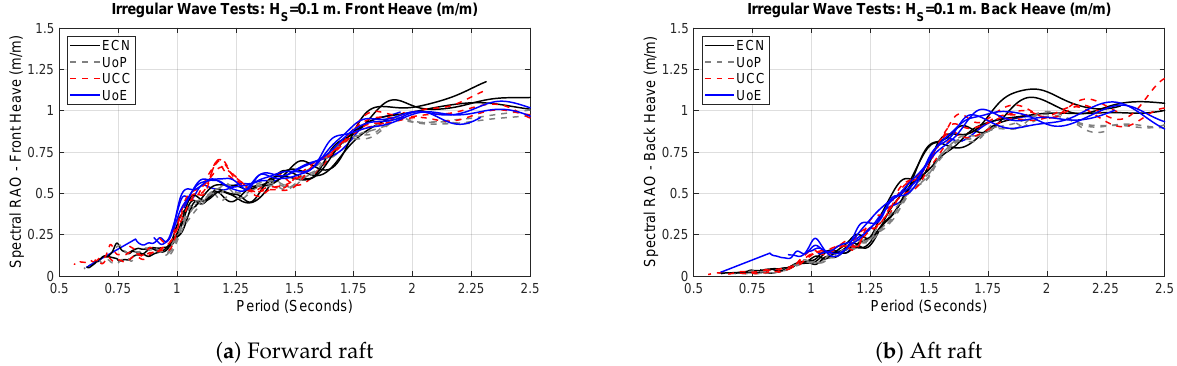
Figure 11. Heave RAO for H s of 0.1 m across facilities.